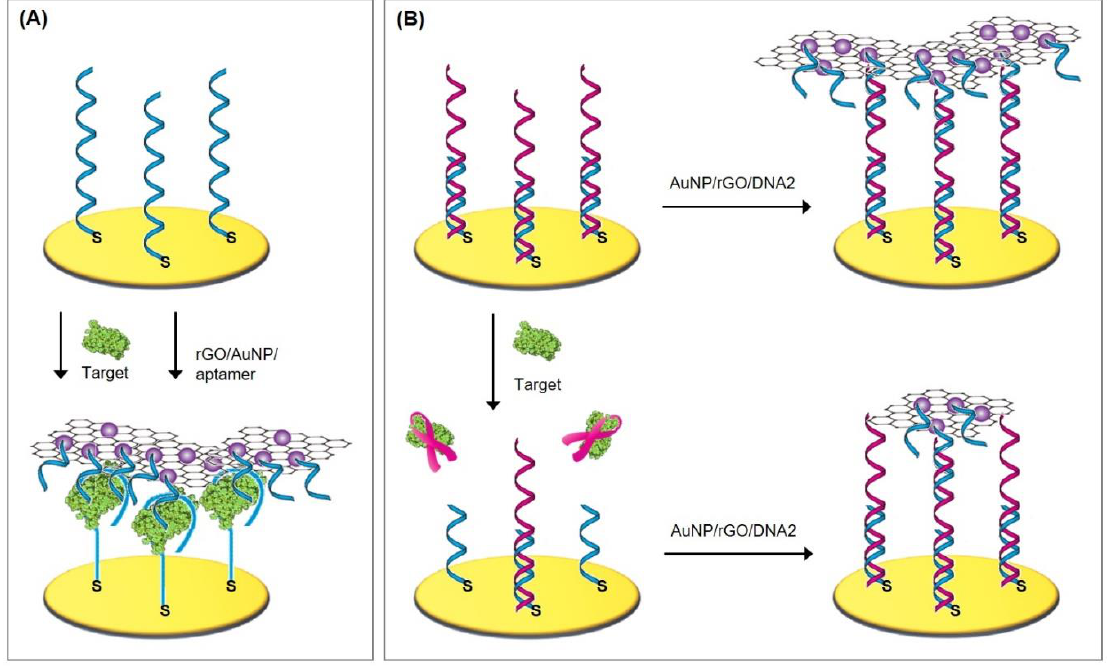
Figure 18. Signal amplification strategies based on graphene nanosheets, employed by ( A ) Wang et al. [111] and ( B ) Jiang et al.